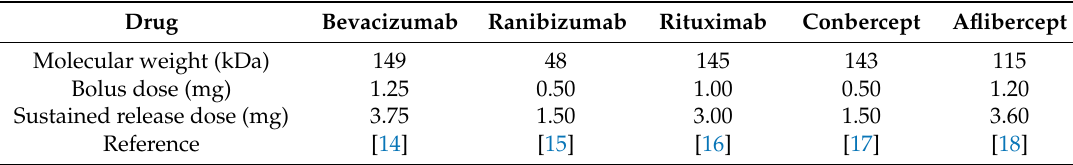
Table 2. Drug-related